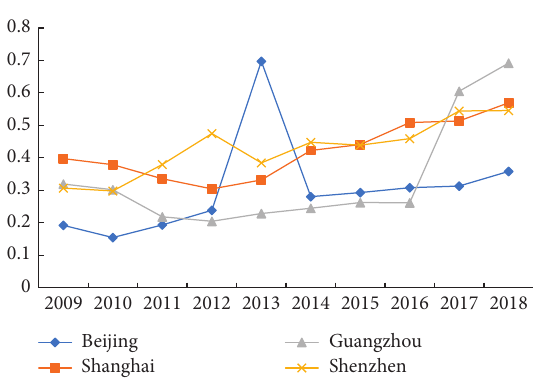
Figure 3: 2009–2018 Beijing, Shanghai, Shenzhen, and Guangzhou urban green investment.